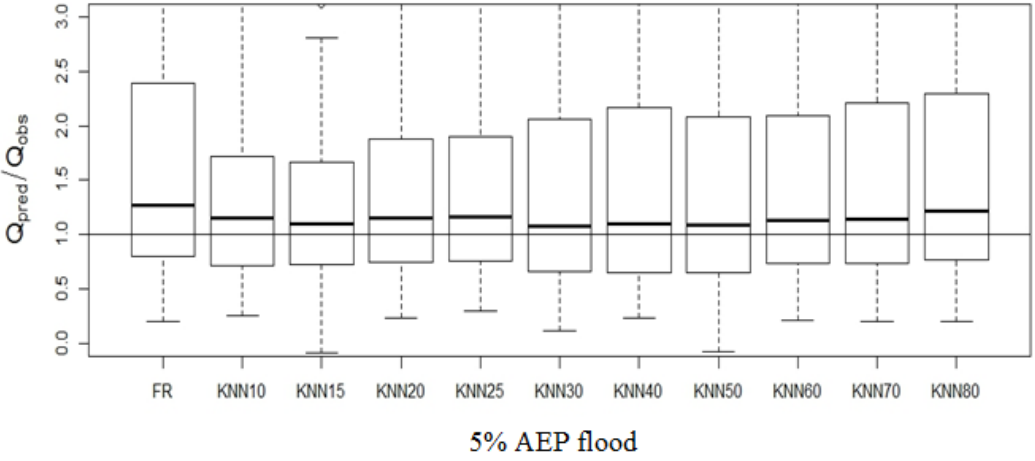
Figure 5. Boxplots for Q pred / Q obs of fixed region (FR) and ROI (in case of 5% AEP flood).